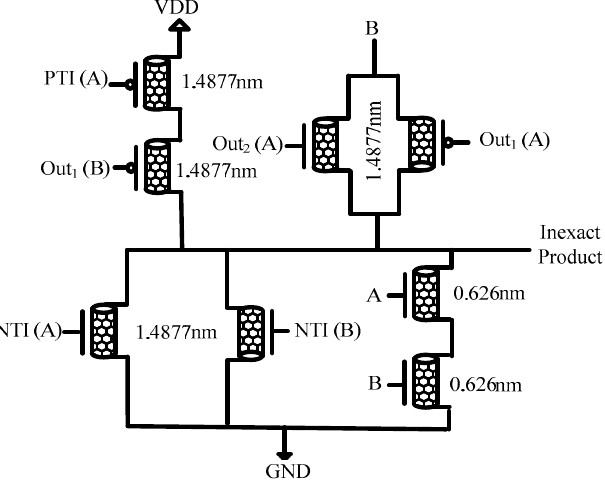
Figure 5. Schematic design of the first proposed inexact design.